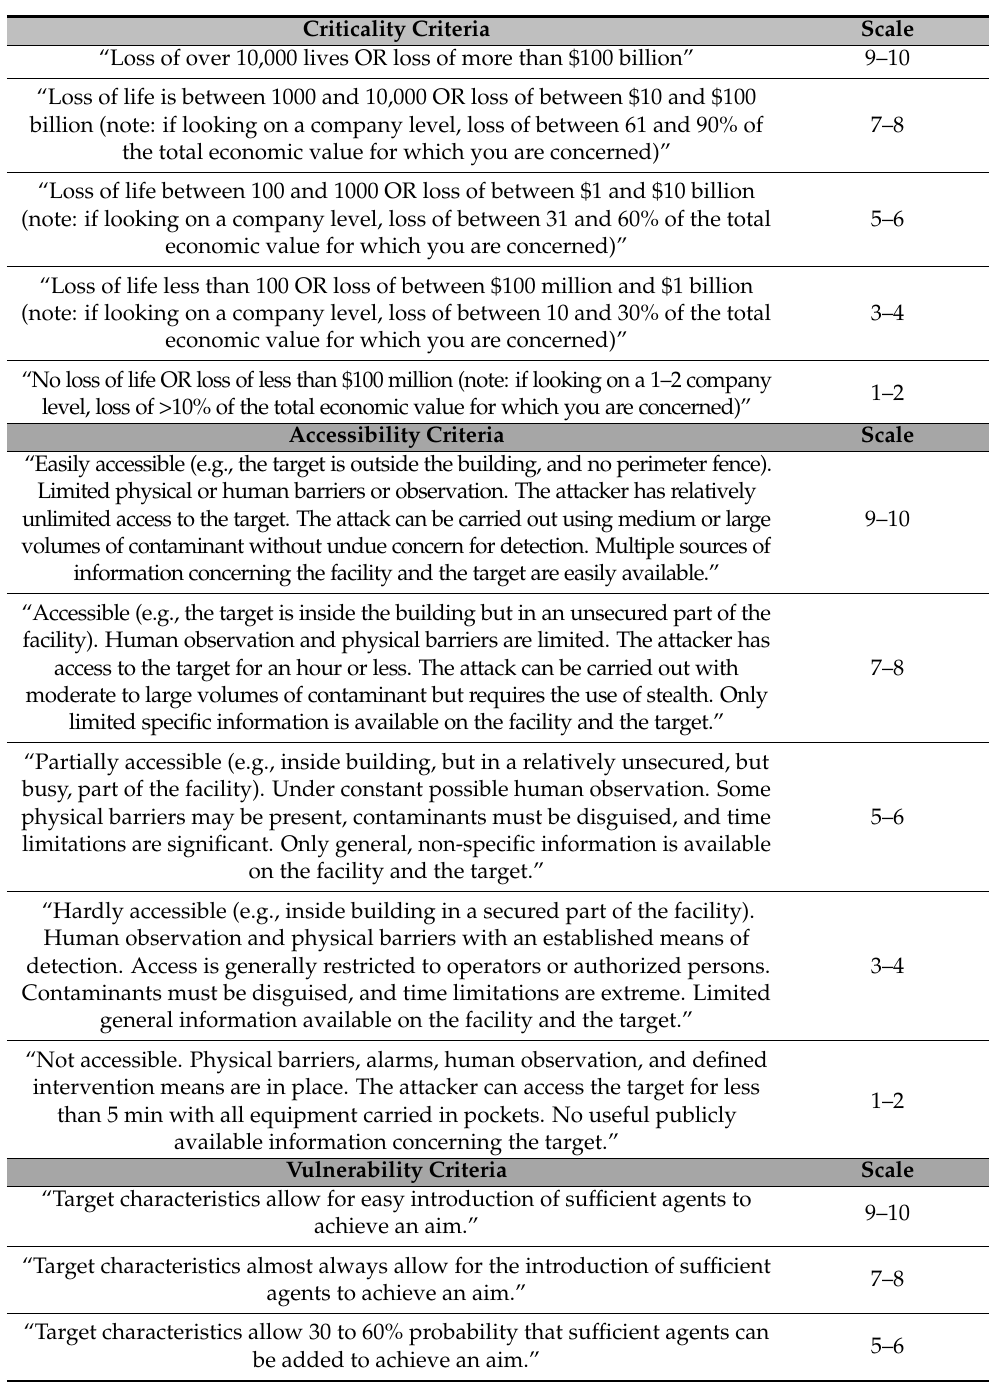
Table 3. CARVER+Shock criticality grading scales. Source: